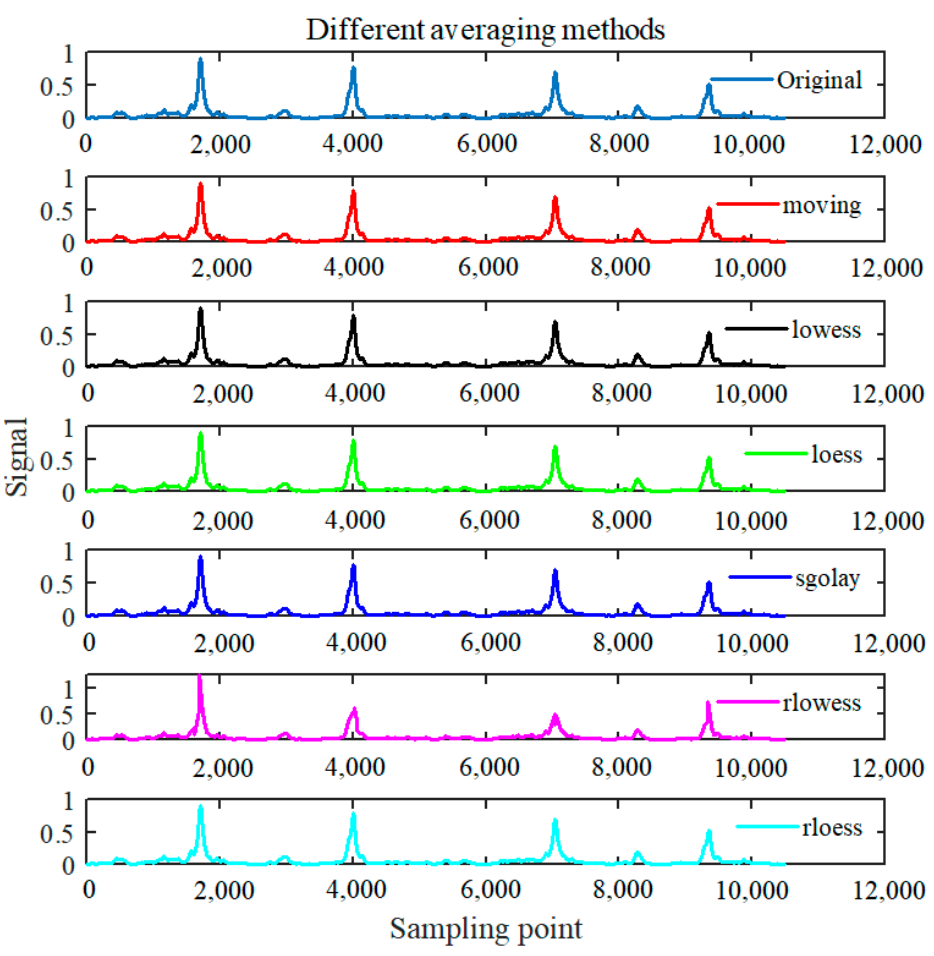
Figure 9. Signals processed by different averaging methods.